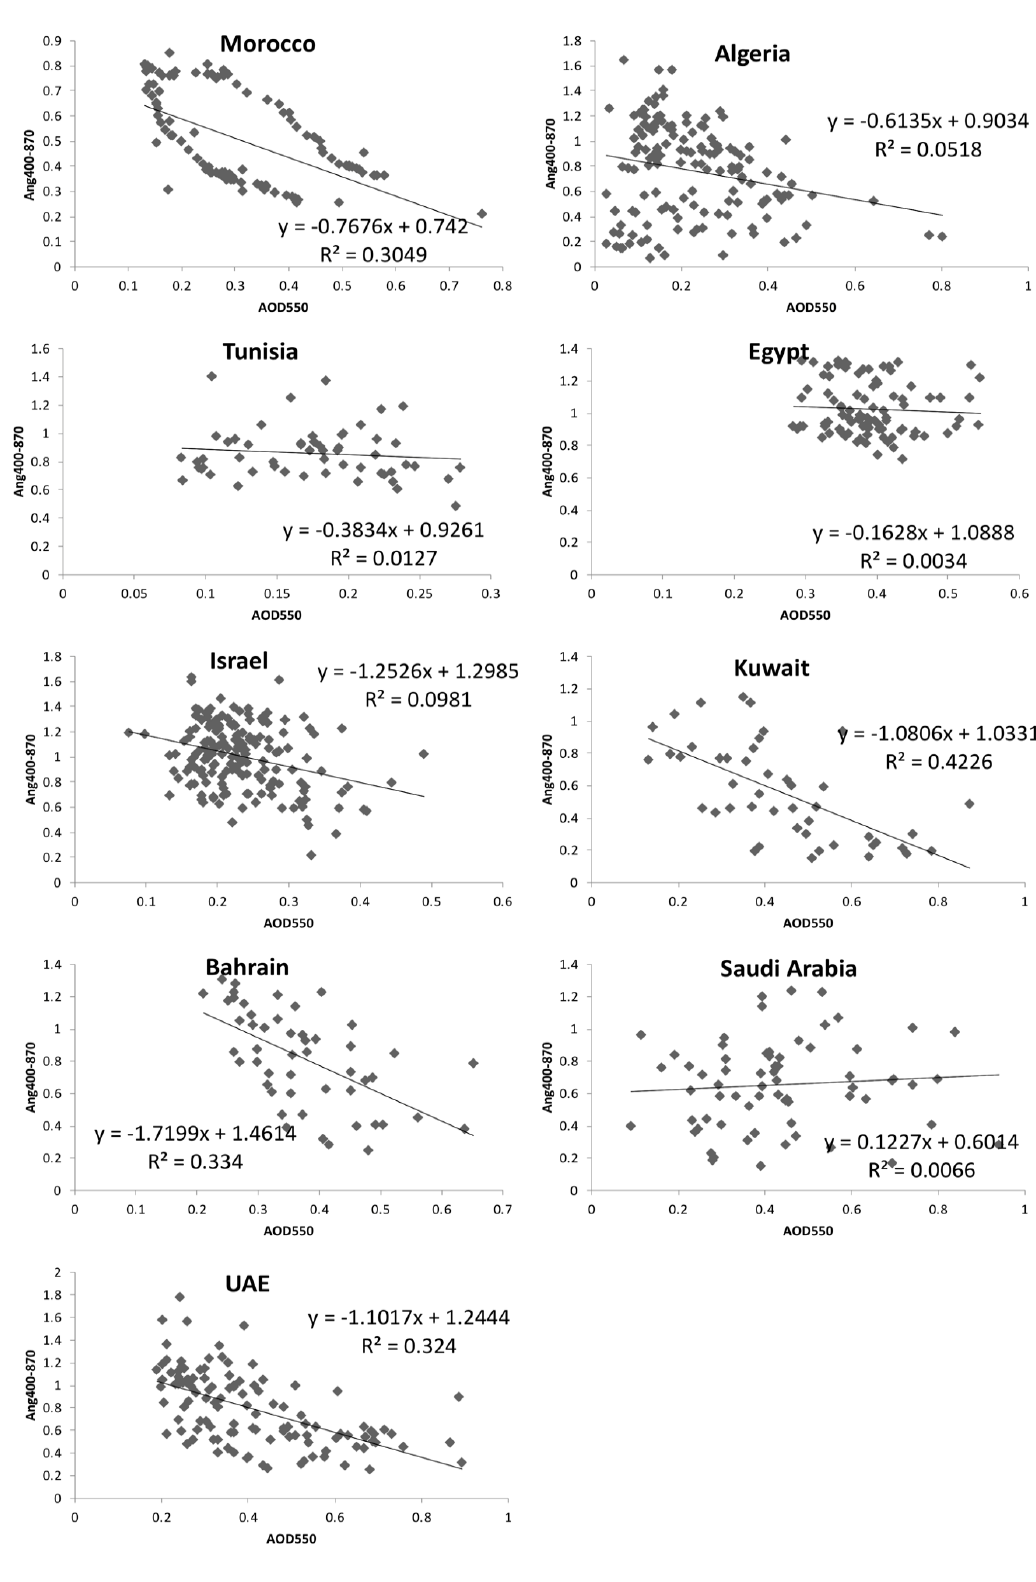
Figure 9. Scatter plot for the MENA region countries for the relationship between the Ang400-870 and the AOD550.